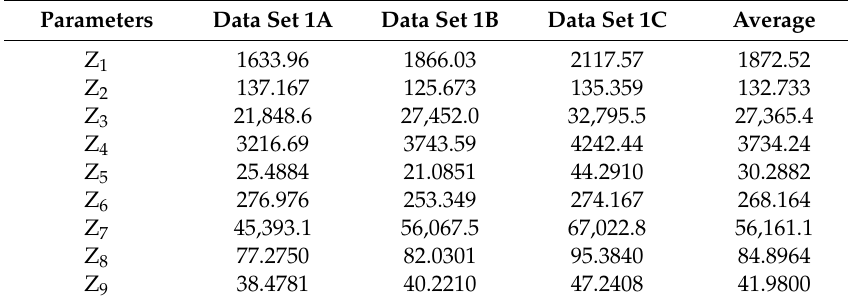
Table 2. Averages of the µ * values across the nine sensitivity analysis (SA) runs of each data set in Category 1, the data from experiments using 20 wt% Co / SiO 2 catalyst.